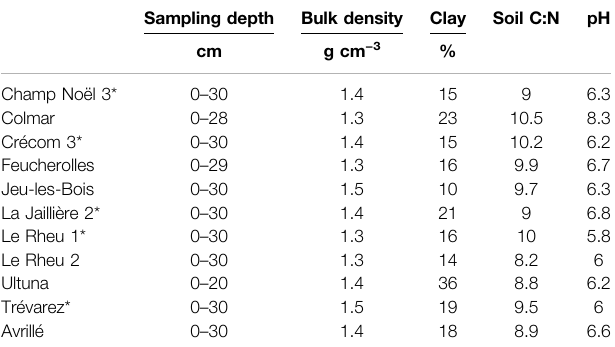
TABLE 2 | Soil properties for the minerally unfertilized and fertilized* control treatments at the beginning of the experiment. More information on the experimentscanbefoundinClivotetal.(2019),Kättereretal.(2011),Levavasseur et al. (2020) and Bruni et al.